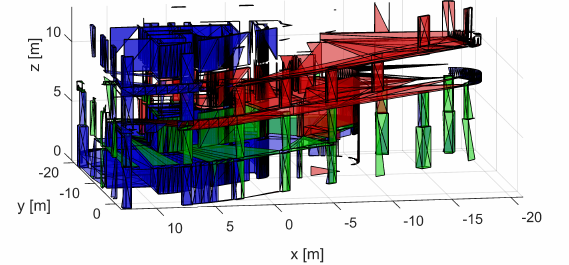
Figure 8. Result of the visibility checks for the point cloud of time step 1 (Figure 5). Green triangles are labeled as potentially built , blue triangles are labeled as not visible and red triangles are labeled as not built .